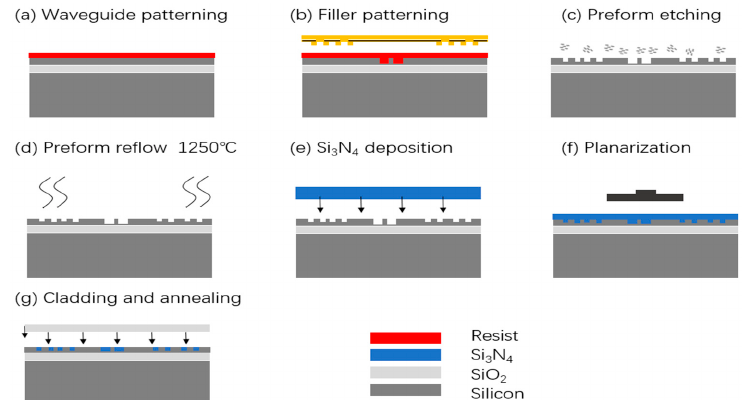
Figure 8. Schematic process flow of the photonic Damascene process. ( a ) Waveguide patterning. ( b ) Filler patterning. ( c ) Preform etching. ( d ) Preform reflow at 1250 ℃ . ( e ) Si 3 N 4 deposition. ( f ) Planarization. ( g ) Cladding and annealing.